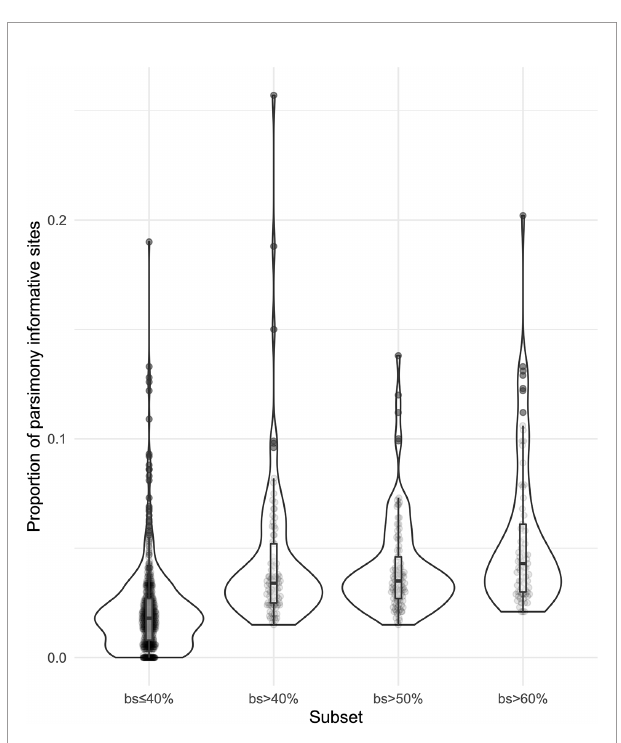
FIGURE 2 | Violin plots showing the distribution of the proportion of parsimony informative sites for the subsets of